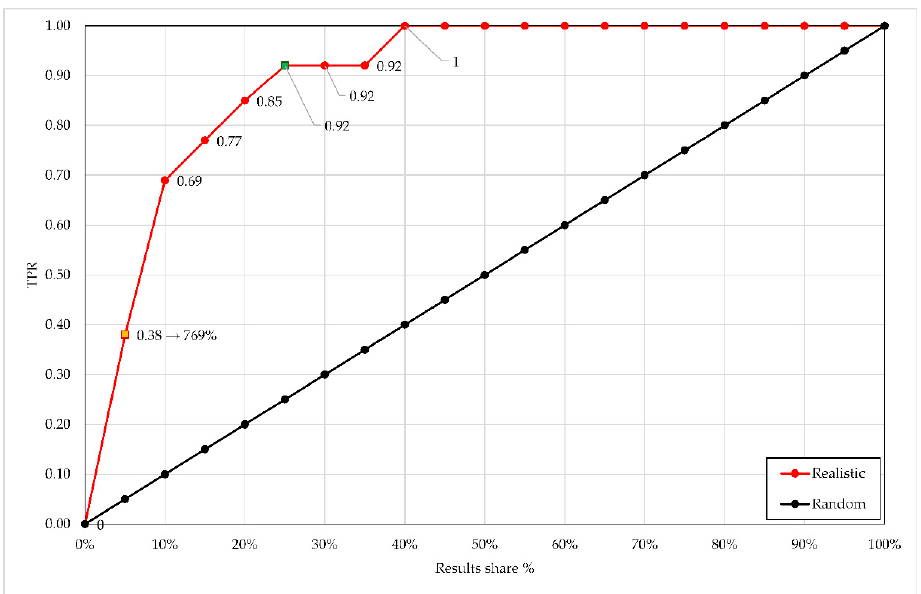
Figure 5. Lift chart of a classifier used in the study (red line) compared to random guess (black line) with the maximum lift (orange marker) showing a 769% improvement in True Positive Rate (TPR).